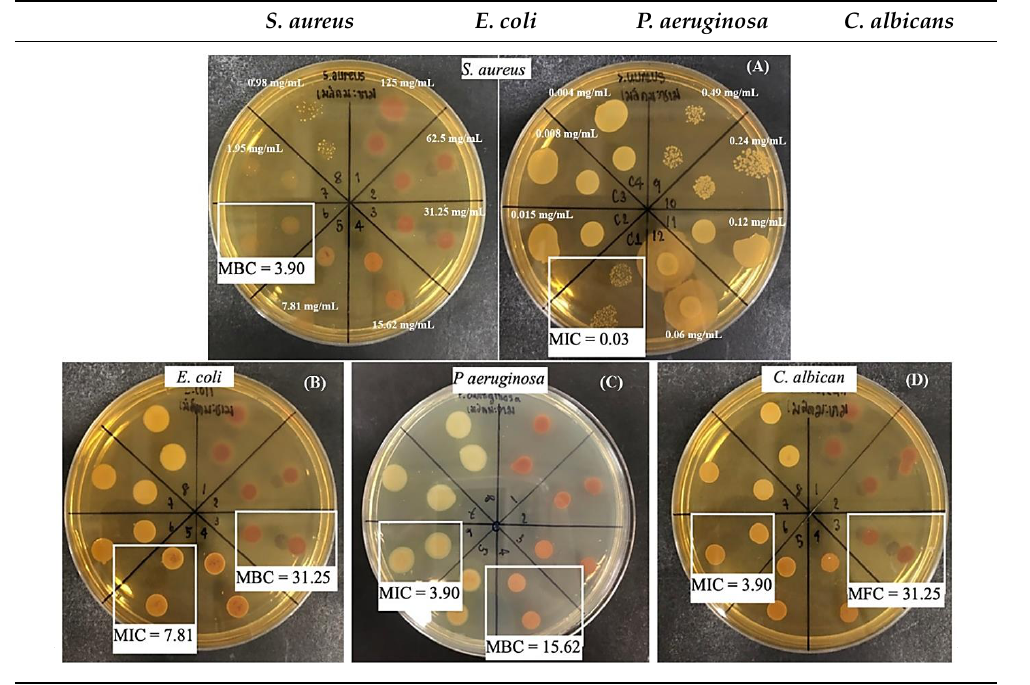
MBC to S. aureus ; 0.03 and 3.90 mg/mL (A), manifested the potent activity of TS